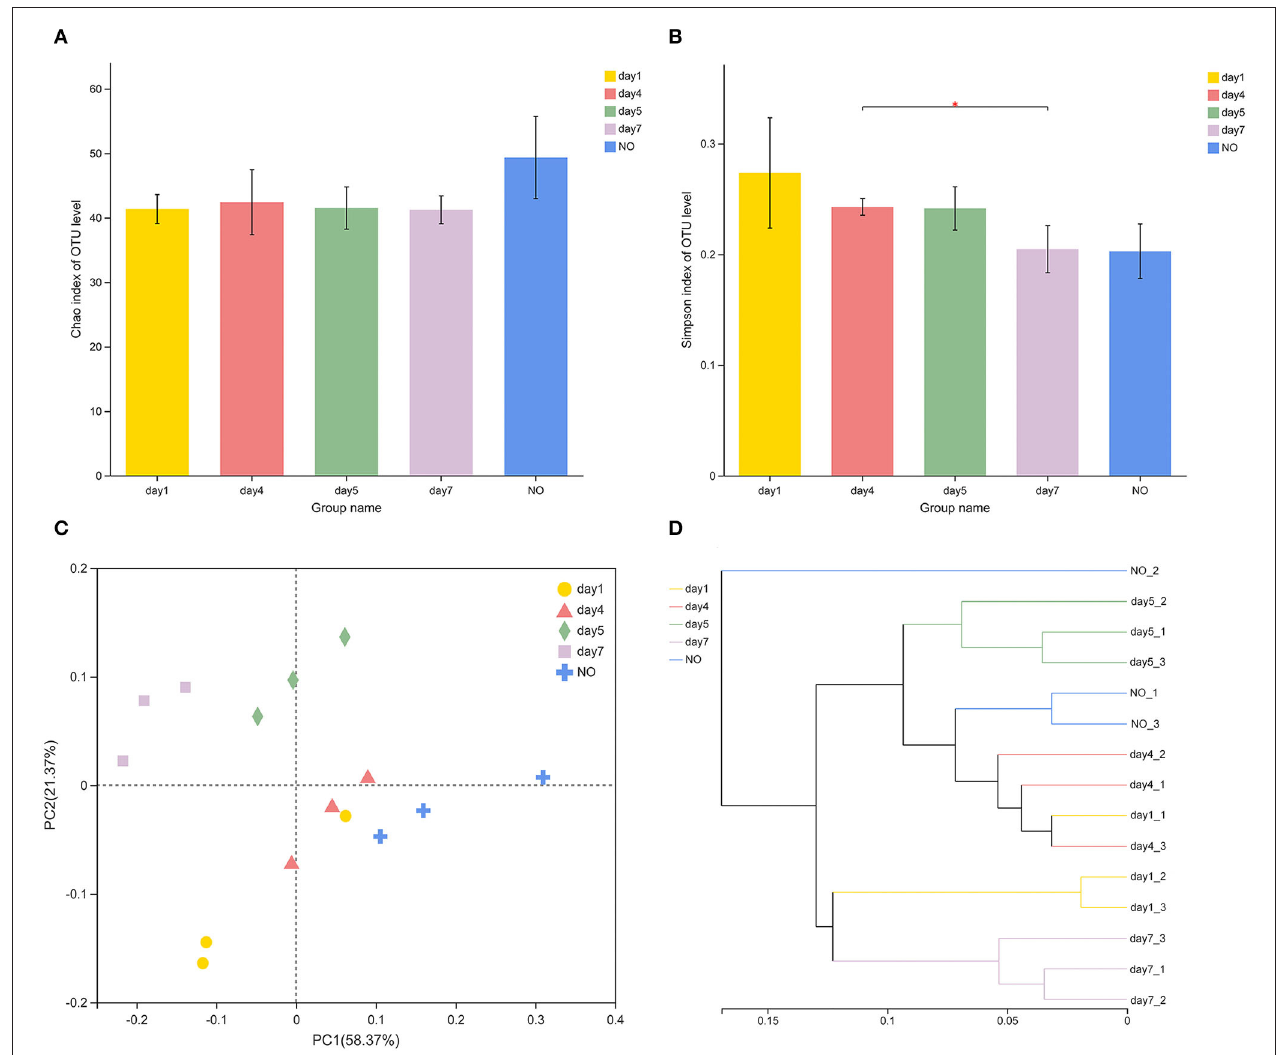
FIGURE 2 | Variations in diversity and community structure of different consortium samples. (A,B) Variations of Chao1 and Simpson indexes * P < 0.05 (Student’s t -test); (C) principal coordinate analysis based on Bray–Curtis distances; (D) hierarchical cluster analysis using the Ward’s method at the genus